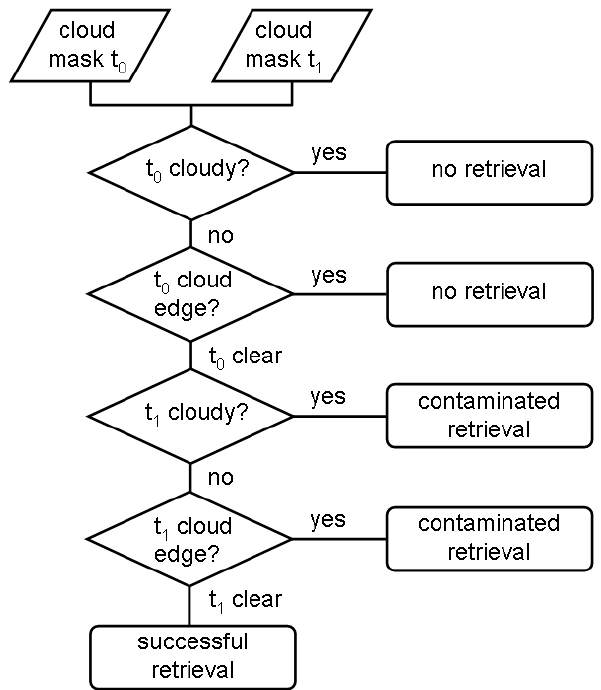
Fig. 1. Decision tree to determine if a trace retrieval will be done at t 1 , and if this retrieval will be successful or cloud